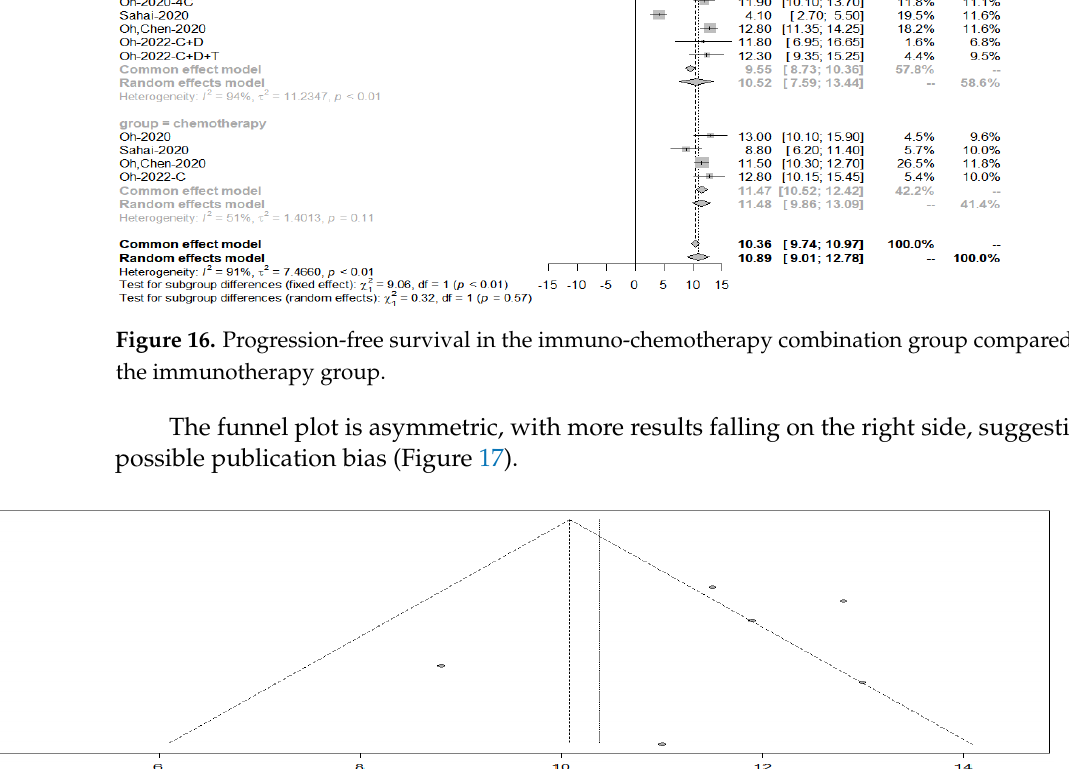
Figure 17. Funnel plot of progression ‐ free survival in the immuno ‐ chemotherapy combination group compared to the immunotherapy group.